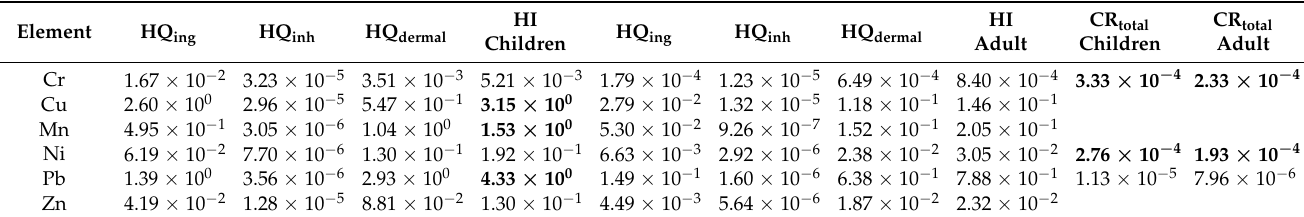
Table 5. Human health risk assessment for children and adults.